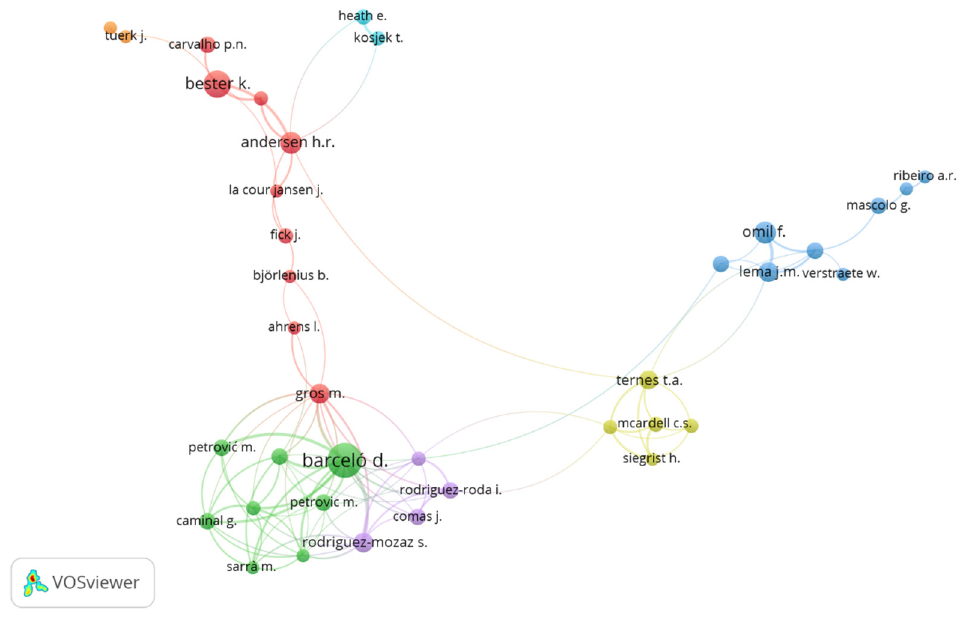
Figure 3. Network of cooperation based on co-authorship of the main authors.